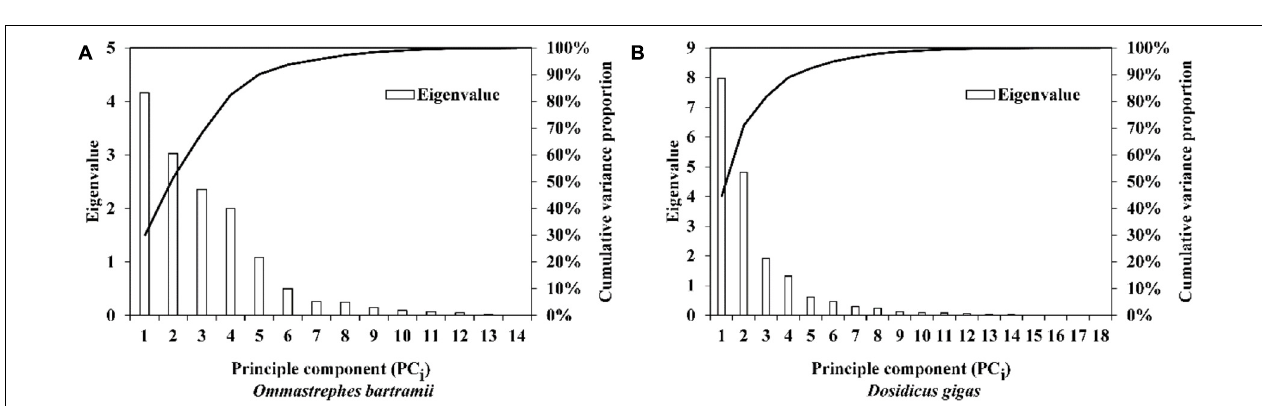
FIGURE 3 | Overall, annual and interannual trends (annual: Cyclical series of abundance, CA, interannual: trend series of abundance, TA) based on Hodrick—Prescott filter analysis for (A) Ommastrephes bartramii and (B) Dosidicus gigas.